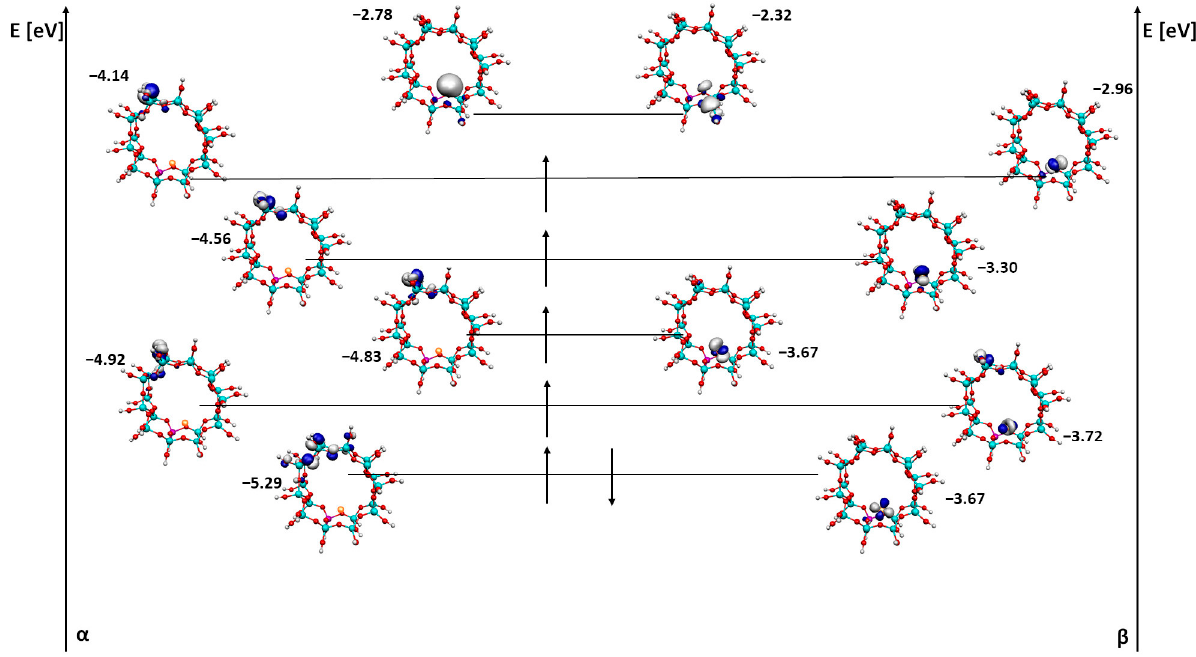
Figure 3. HOMO, SOMO and LUMO alpha and beta orbitals for ZSM-5 with Fe adsorbed next to the active site. active